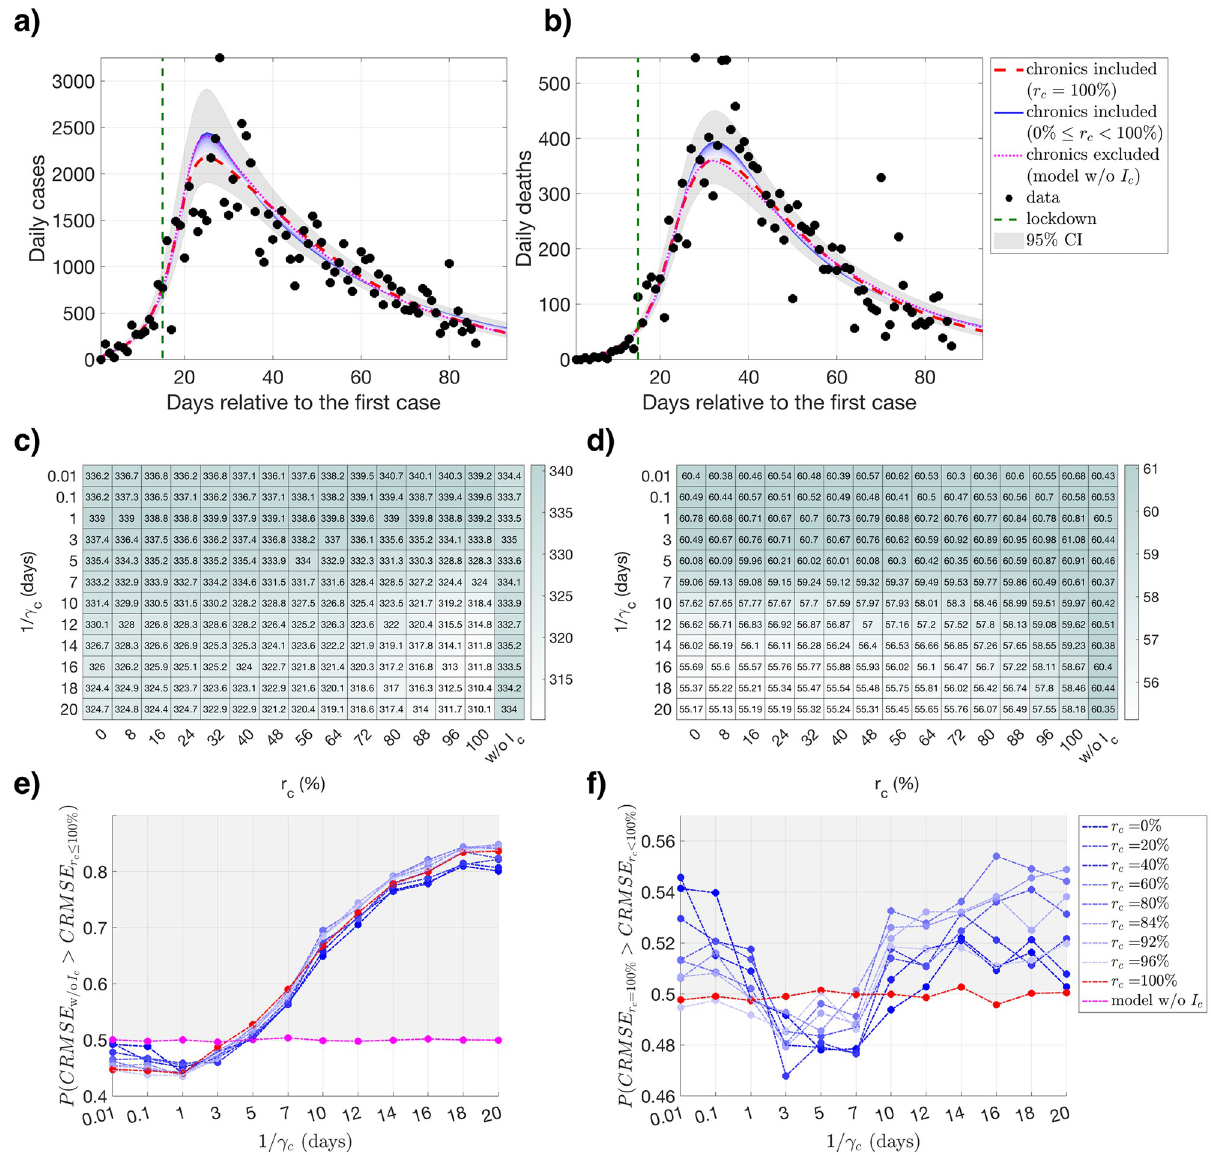
Fig 2. Fitting and Root Mean Squared Error (RMSE) results for Lombardy. Fitting and RMSE results for Lombardy, calculated using different levels and durations of infectiousness for the chronically infected population. Model outcomes (presented for 1/ γ confimed cases and b) daily deaths using the data until the introduction of relaxation for model fitting, respectively. Darker shades of blue represent the fitting results with increased infectiousness of the chronically infected population, i.e., lower r r c = 100% are drawn in red, and the fitting results for the model without the I c compartment (model w/o I c ) are drawn in pink. Data points that are used for fitting are drawn in black. Gray areas around the model outcomes represent the union of the 95% confidence intervals calculated for all models. RMSE values c) for the number of daily confirmed cases and d) the number of daily deaths for a given r I c represents the results for the model without the I c compartment. e) Probability of the model without the I c compartment (model w/o I c ) having a greater combined RMSE (CRMSE) value than the model with the I γ c values. f) Probability of the model where individuals are being diagnosed without being infectious ( r c = 100%) having a greater combined RMSE (CRMSE) value than the model with individuals with a a prolonged infectiousness ( r represent the models that are providing a better fit more frequently than e) the model without the I c compartment (model w/o I c ) and f) the model with r c =